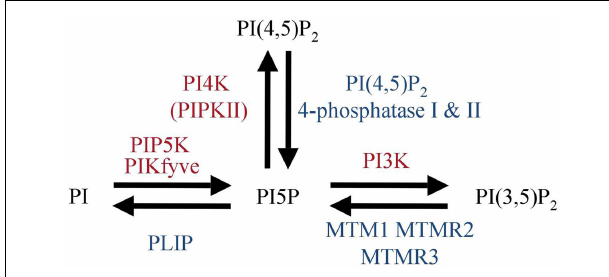
FIGURE 1 | Mammalian enzymes involved in PI5P